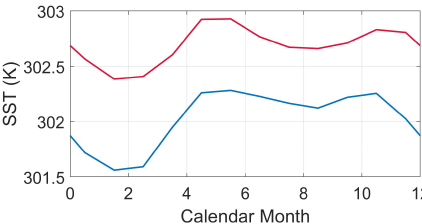
Figure 6. Average sea-surface temperature at 6 AM local time, —– : hiatus period, —– : post-hiatus period [43].